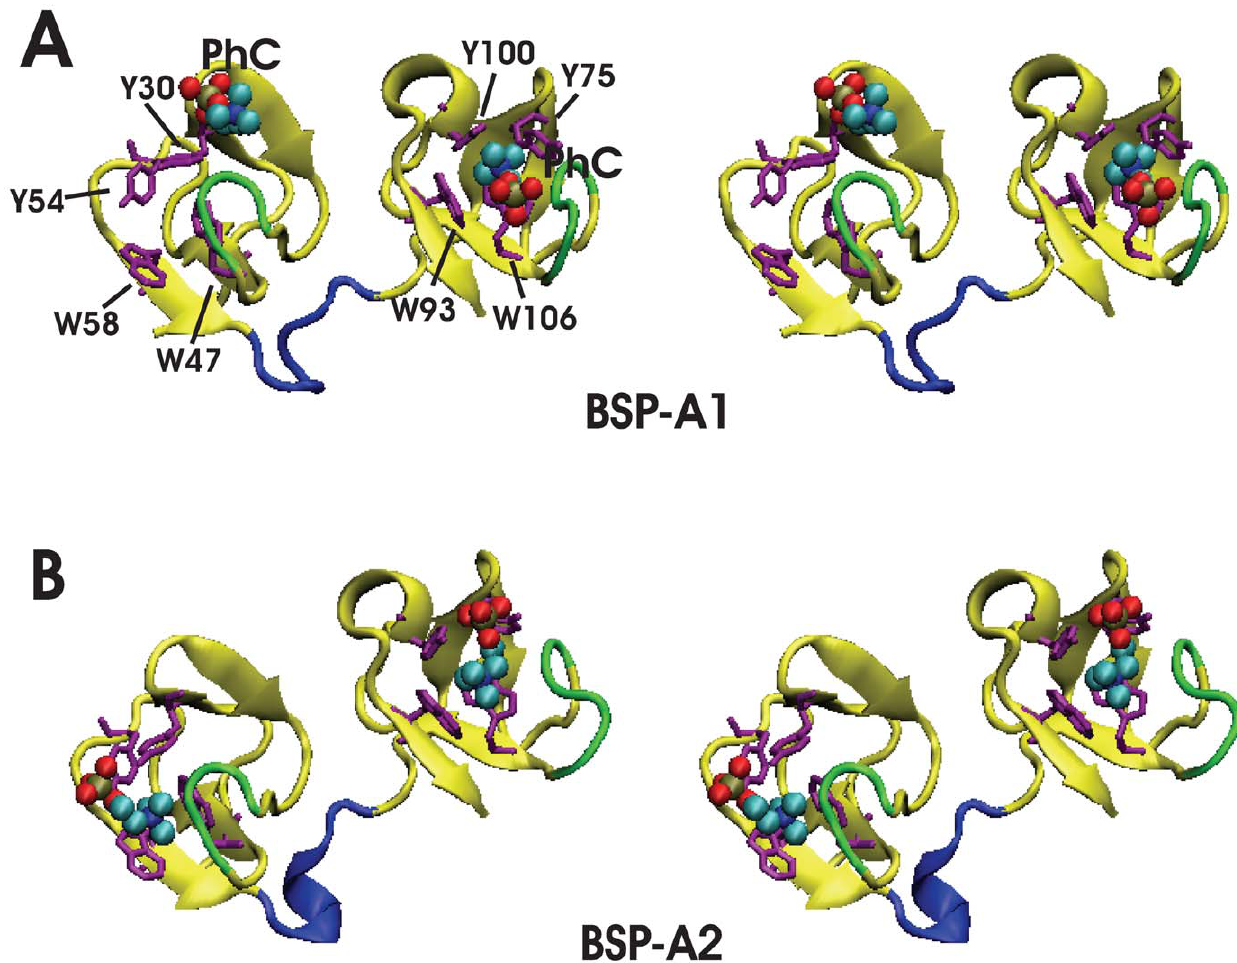
Figure 2. Stereoviews of the homodimer crystal structure of PDC109 complexed with PhCs (PDB ID: 1h8p) [ 24 ] . (A) BSP-A1 protomer and (B) BSP-A2 protomer. Bound PhC molecules are shown as vdW spheres, aromatic sidechains at the PhC binding sites are shown in orange, and loops 1 and 2 that neighbor the binding sites and interact with PhC ligand are denoted in green [74].